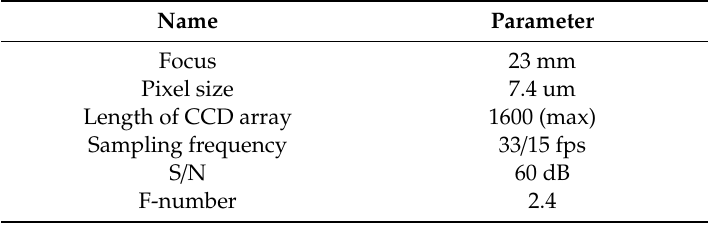
Table 1. Parameters of the